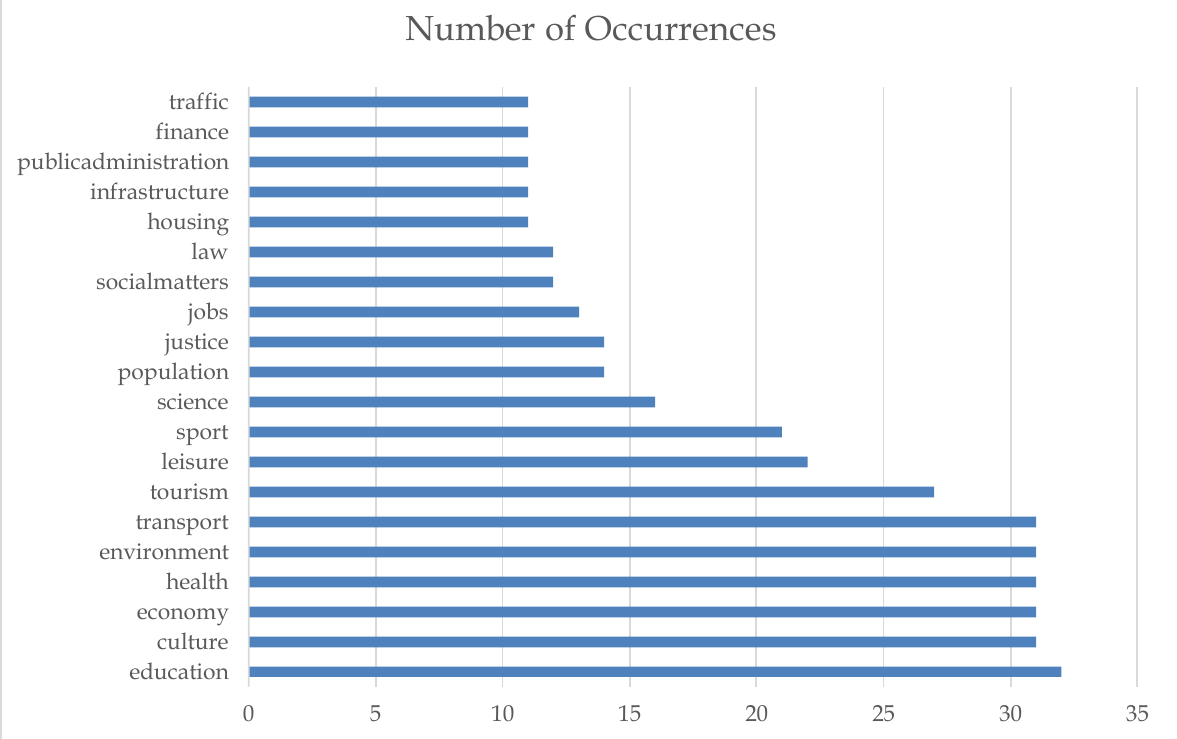
Figure 5: Candidate Categories for a Transnational Semantic